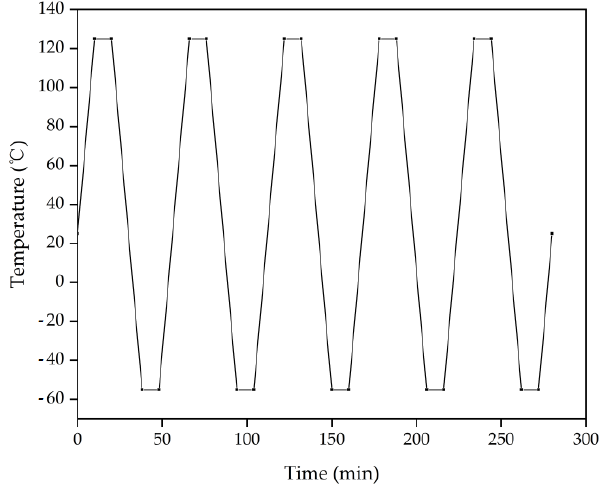
Figure 10. Temperature cyclic loading curve.